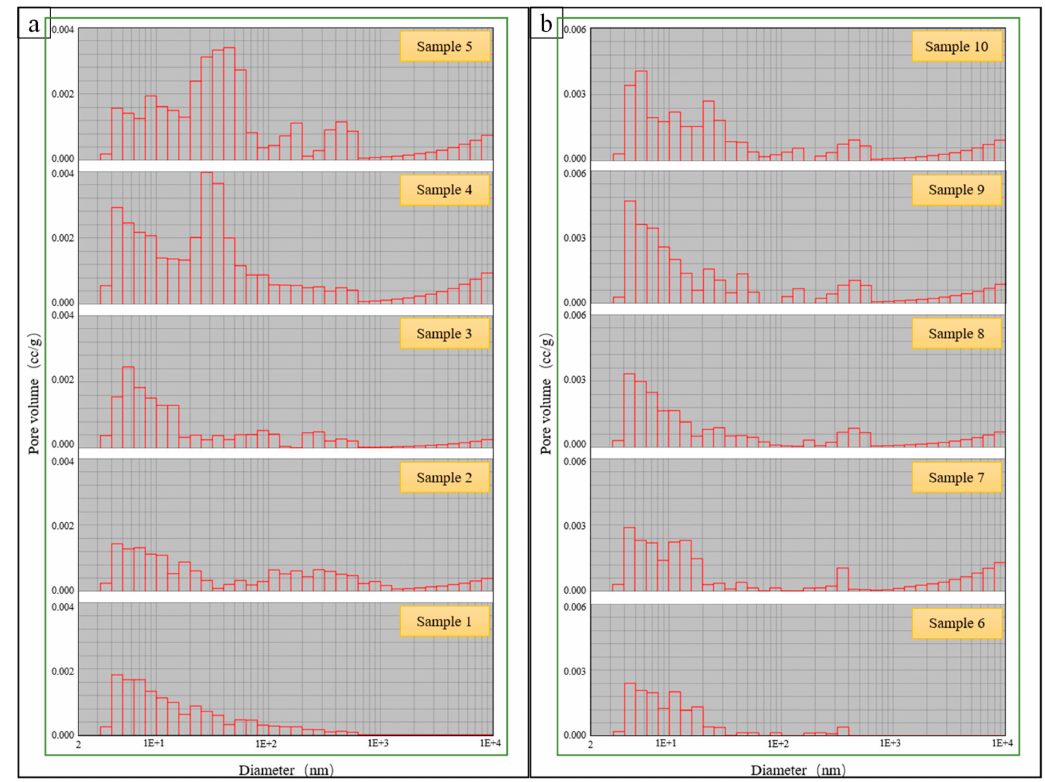
Figure 12. ( a ) Relation diagram of pores with soaking time in shale; ( b ) relation diagram of pores with soaking time in tu ff